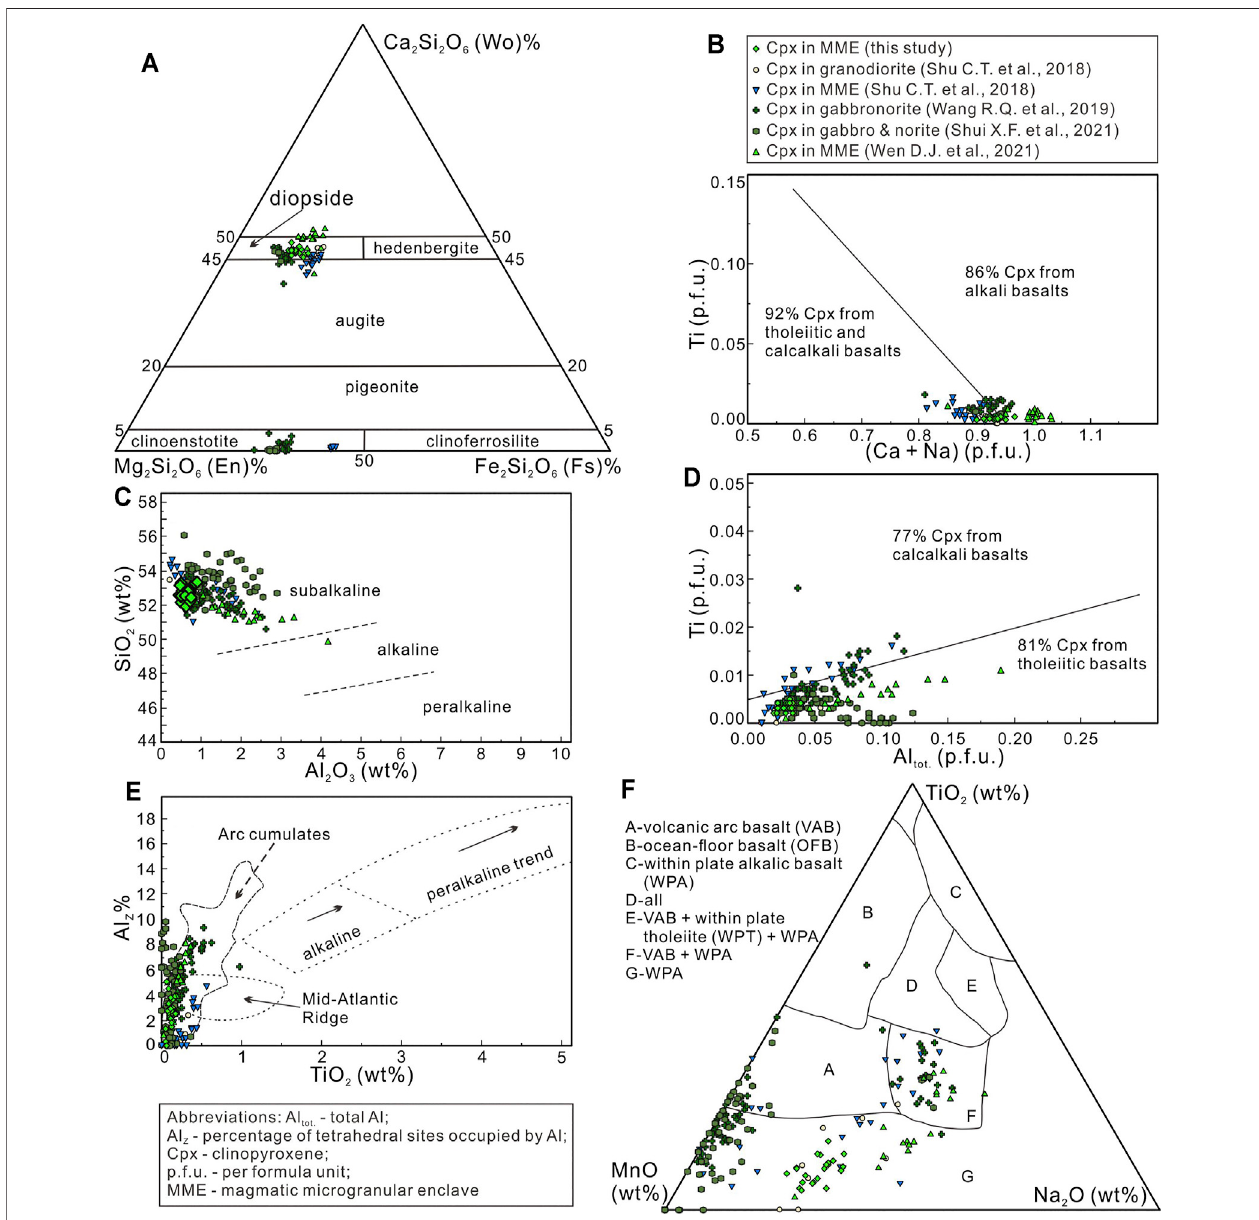
FIGURE14| Classi fi cation and tectonic discrimination ofclinopyroxene. (A) Classi fi cation ofclinopyroxene according tothenomenclature of Morimoto (1988). (B) Discrimination diagram for clinopyroxene phenocrysts from alkaline basalts and other basalts (Leterrier et al., 1982). (C) SiO 2 -Al 2 O 3 covariation in clinopyroxenes from differentmagmatypes(NisbetandPearce,1977). (D) Discriminationdiagramofclinopyroxenesfromcalc-alkalibasaltsandtholeiiticbasalts(Leterrieretal.,1982). (E) Al Z (percentageoftetrahedralsitesoccupiedbyAl)vs.wt%TiO 2 inclinopyroxene(Loucks,1990). (F) TriangulardiagramofTiO 2 -MnO-Na 2 Ofordiscriminatingbetween pyroxenes from different magma types (Nisbet and Pearce,